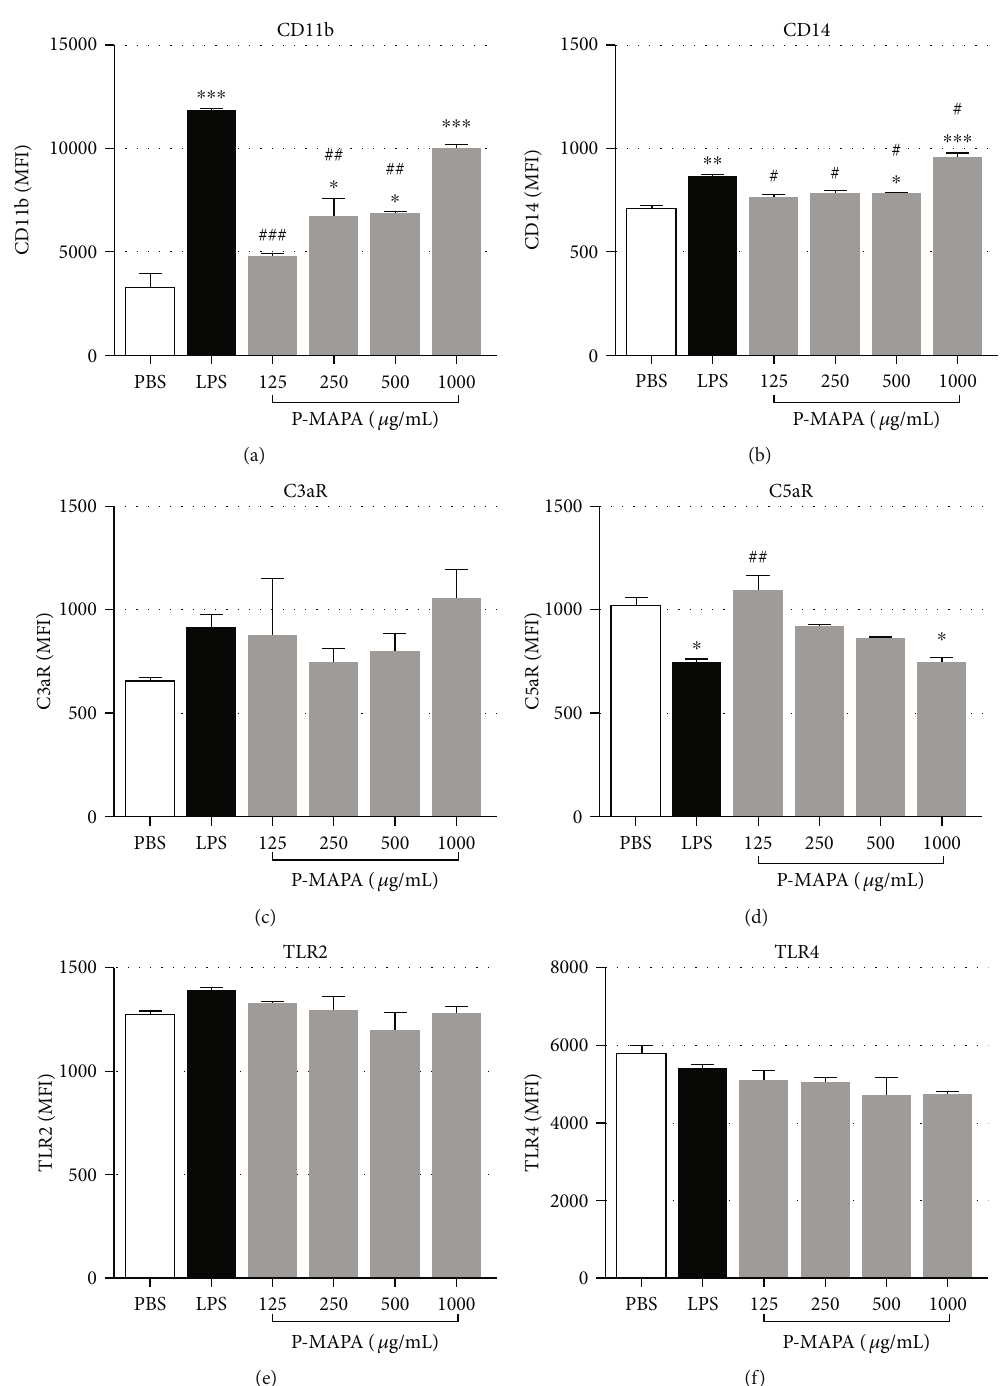
Figure 3: Modulation of surface receptors in neutrophils after P-MAPA treatment. After incubation of blood samples with PBS, LPS (100 μ g/mL), or P-MAPA (125, 250, 500, or 1000 μ g/mL) for 30 minutes at 37 ° C, erythrocytes were lysed, and leukocytes were stained for fl ow cytometry analysis. (a) CD11b, (b) CD14, (c) C3aR, (d) C5aR, (e) TLR2, and (f) TLR4 expressions in neutrophil population. Data are